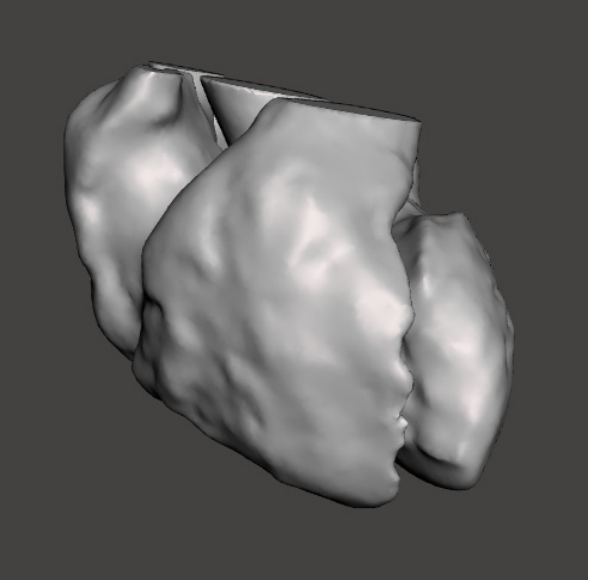
Figure 3. Blood pool model, as obtained after segmentation and